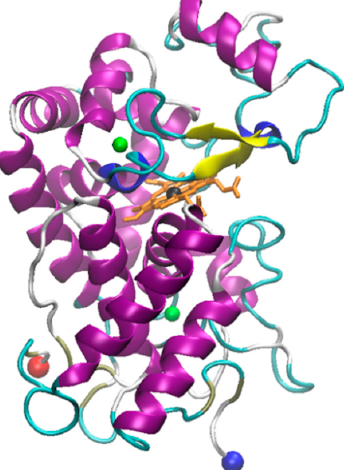
Figure 4. 3D Structure of horseradish peroxidase from Armoracia rusticana . The crystal structure was solved by Hajdu and coworkers; downloaded from rcsb.org (1W4Y) [145,186]. The structure was visualized using VMD. The N- and C-termini are shown as red and blue spheres respectively while the calcium ions are shown in green, the heme in orange and the heme-iron in black .